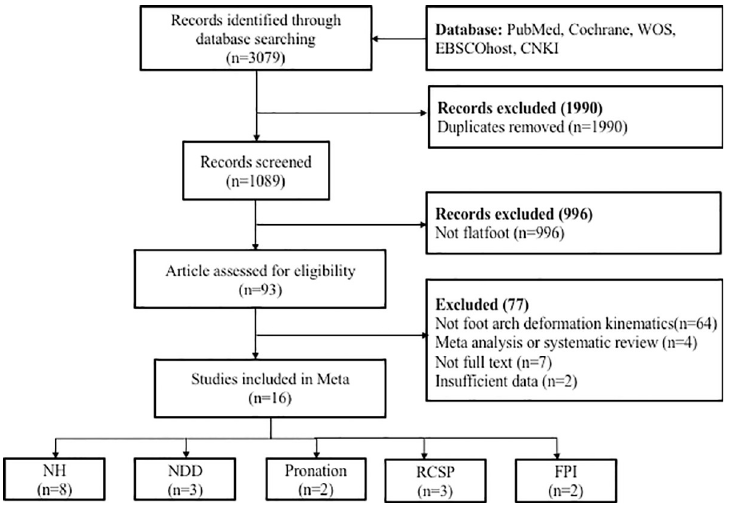
Fig 2. Flow chart. Navicular Height; NDT: Navicular Drop Distance; RCSP: resting calcaneal stance position; FPI: Foot posture index.